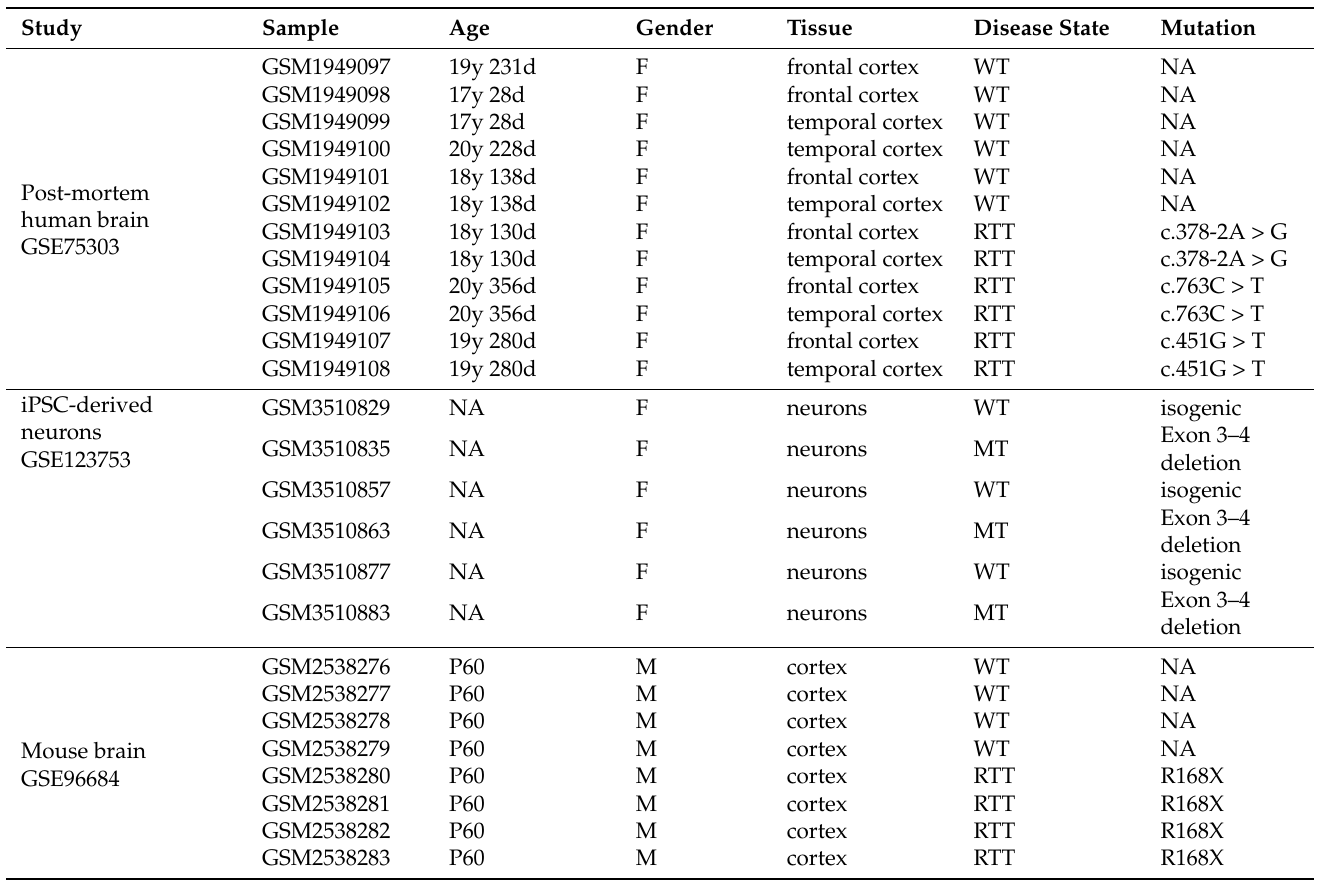
Table 1. Summary of samples used in WGCNA. WT refers to wild type, RTT refers to Rett Syndrome and NA refers to not applicable; F refers to feminine and M to